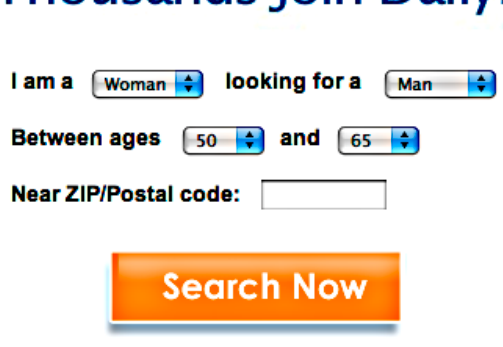
Figure 3. “Quick Browse” box from OurTime.com [38].